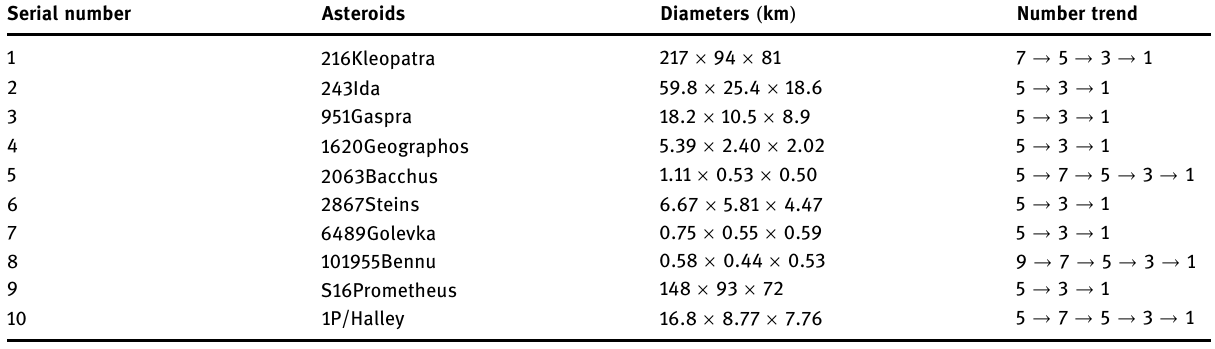
Table 4: The trend of the equilibrium points number of ten asteroids when the spin speed increases